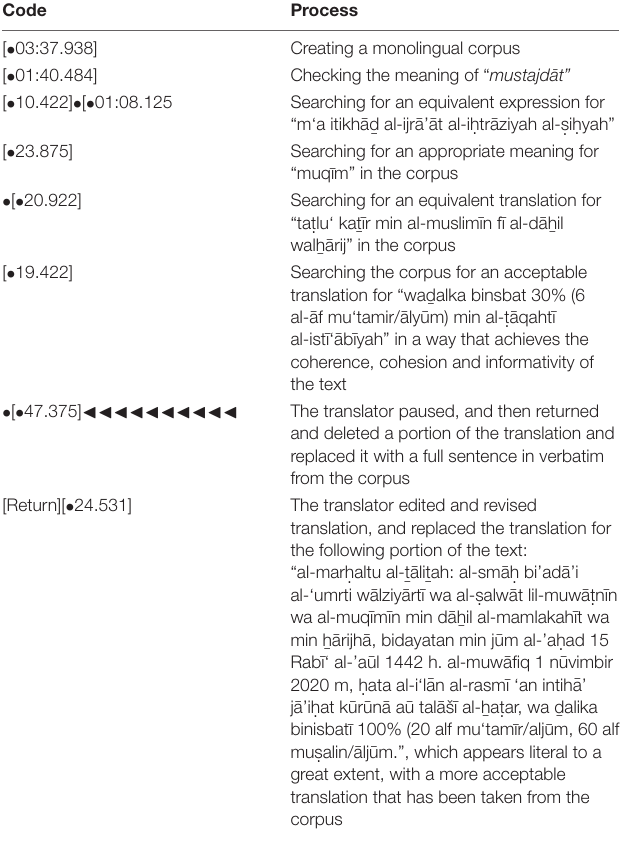
TABLE 3 | User events during the translation